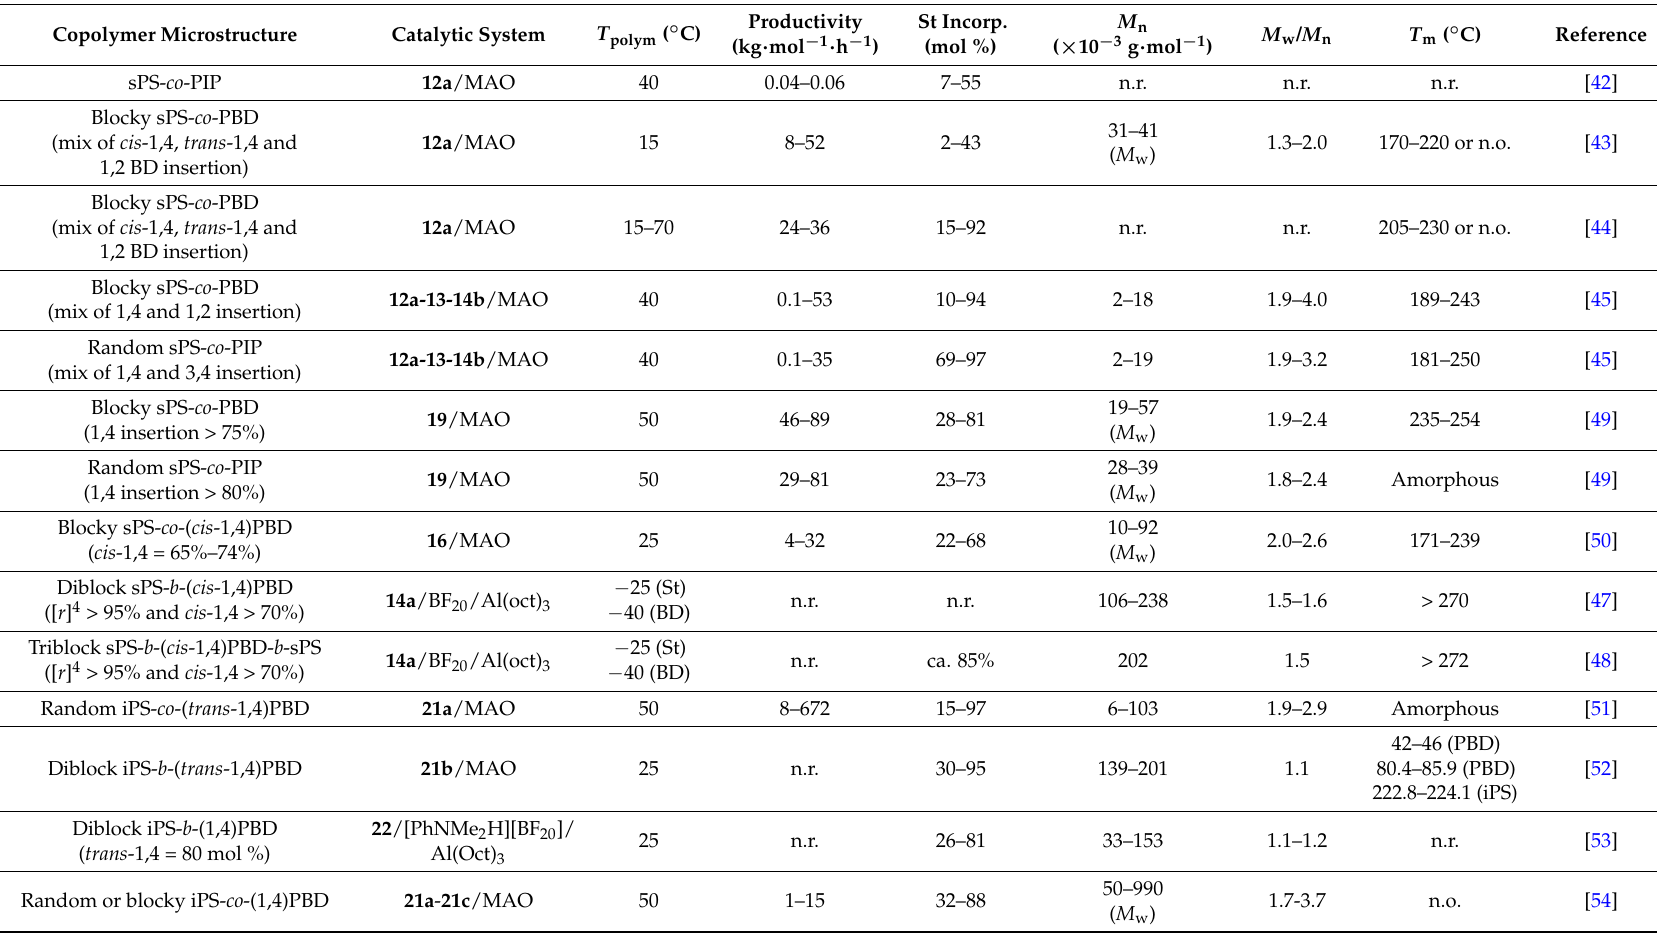
Table 3. Stereoregular styrene-butadiene and styrene-isoprene copolymers: catalytic system and polymer